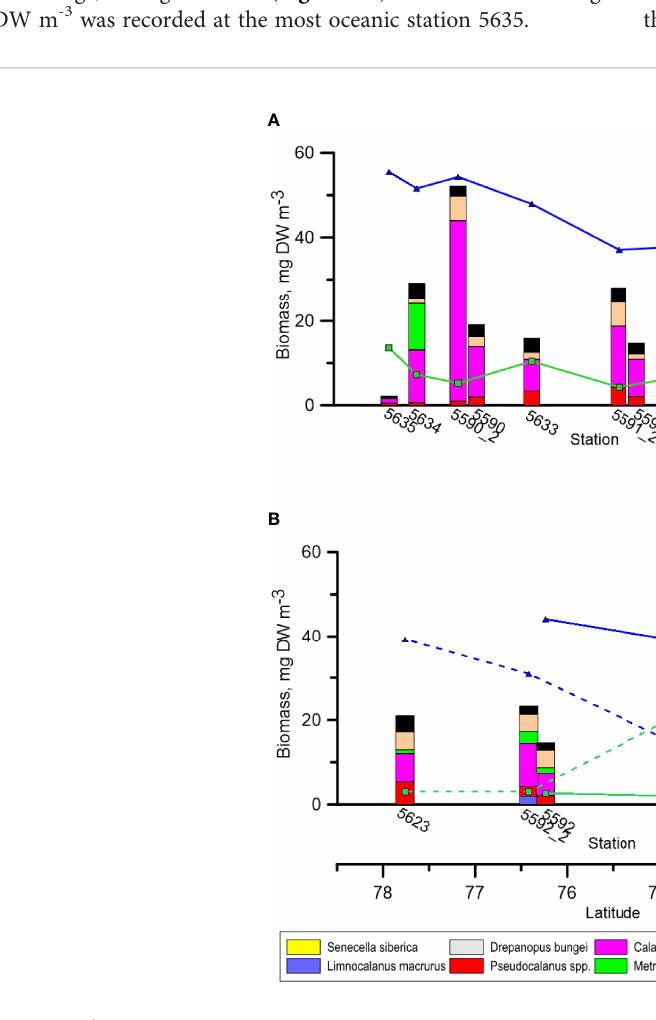
FIGURE 3 | Distribution of zooplankton biomass, surface salinity and Chlorophyll a (0-bottom at the shallow station, 0-50 m at the deep stations) along the transects. (A) – Khatanga transect, (B) – Lena transect. Bars – zooplankton biomass, blue line - salinity (S), green line - chlorophyll ɑ Dashed lines – salinity and chlorophyll a at the repeated stations along the Lena transect. At the repeated stations along the Khatanga transect, the values of salinity and chlorophyll ɑ almost did not change and thus are not shown. Note considerable changes in species composition and biomass at st. 5596_2 compared with st.